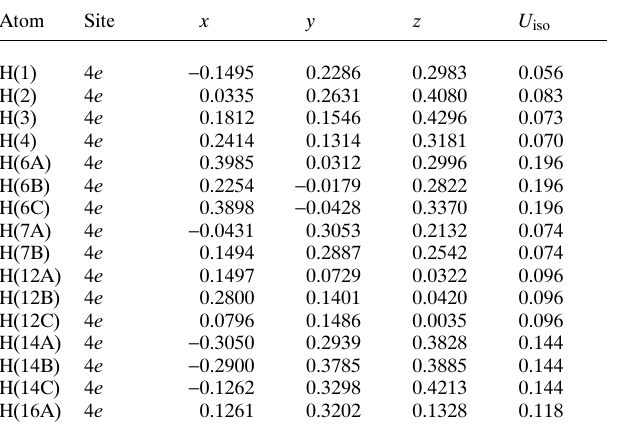
Table 5. Atomic coordinates and displacement parameters (in Å 2 ) .